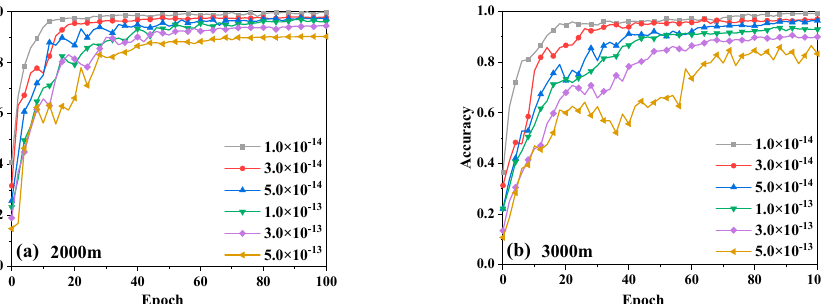
Figure 8. Accuracy of OAM mode recognition based on AP-CNN under different turbulence inten- sities. ( a ) transmission distance: 2000 m ( b ) transmission distance: 3000 m.